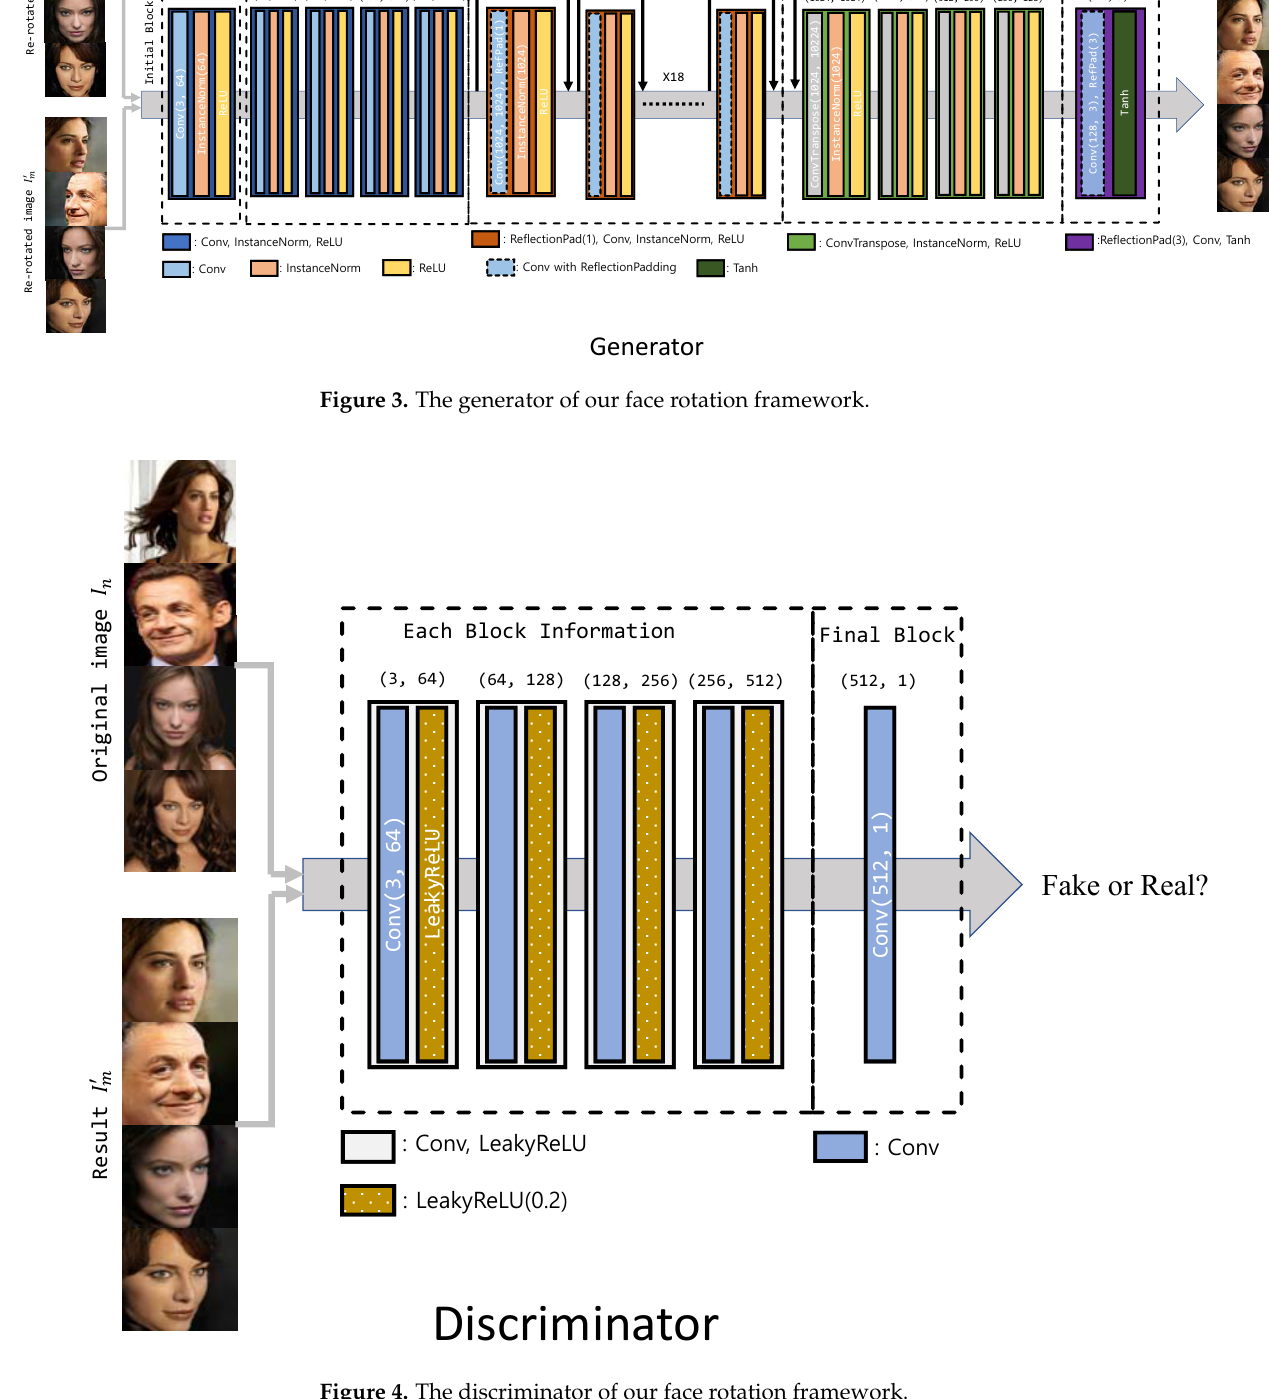
Figure 4. The discriminator of our face rotation